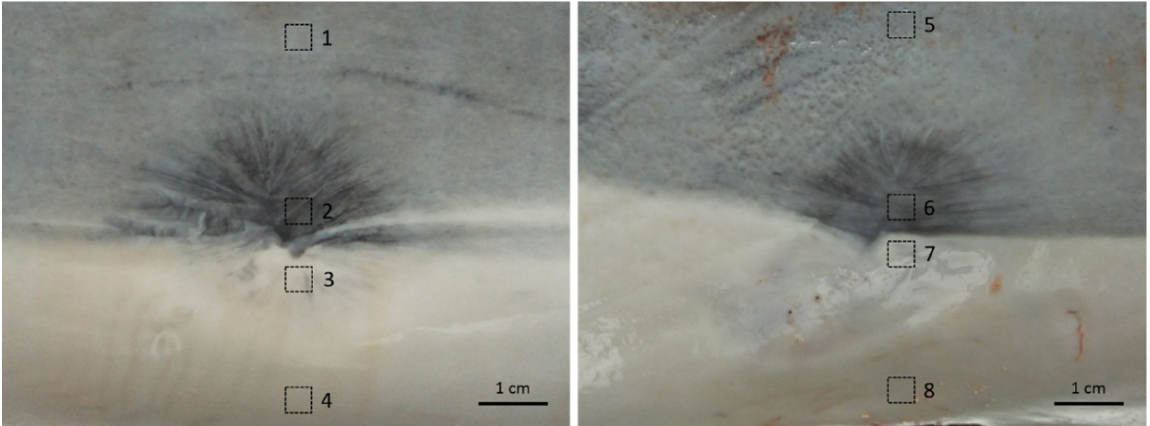
Figure 7. Gross appearance of two full-thickness healed wounds in a Fraser’s dolphin. Site 1 and 5: light-gray unwounded skin; site 2 and 6: gray wounded skin; site 3 and 7: white wounded skin; site 4 and 8: white unwounded skin.